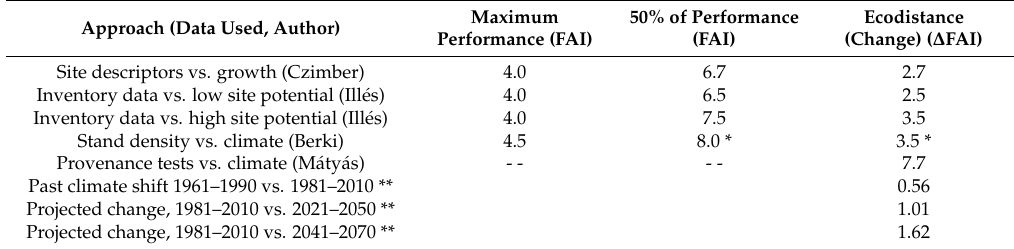
Table 3. Comparison of four approximations of effects of climatic change on growth and vitality of sessile oak, contrasted with recent and projected climatic changes in Hungary.